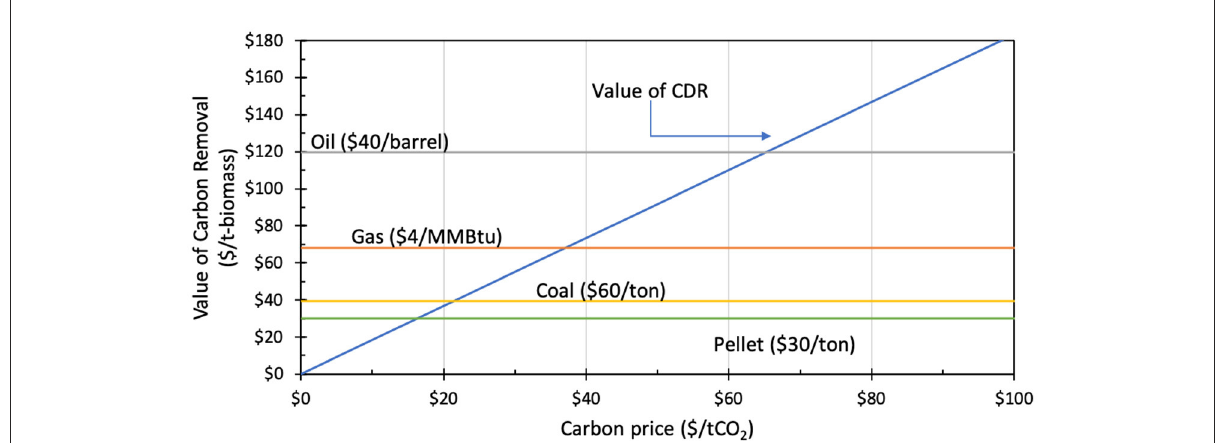
FIGURE1 Change in the CDR value of biomass with increasing carbon price, compared to the value of reference energy sources. Based on figure in ICEF BiCRS report (Sandalow et al., 2020).